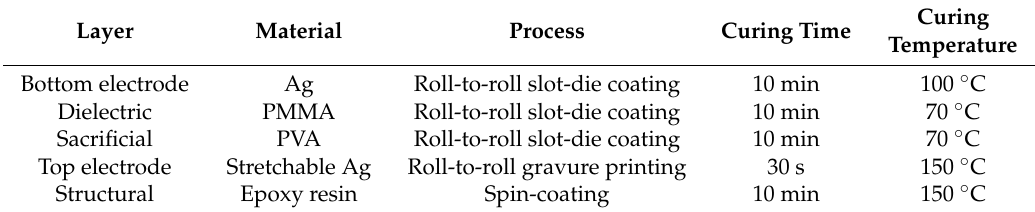
Table 1. Materials and fabrication processes for the air-gap touch sensors.